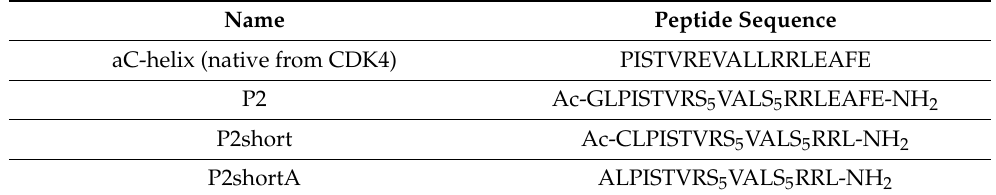
Table 3. Select peptides from CDK4 as noted in the text from [26]. S5 denotes site for olefin staple anchor.